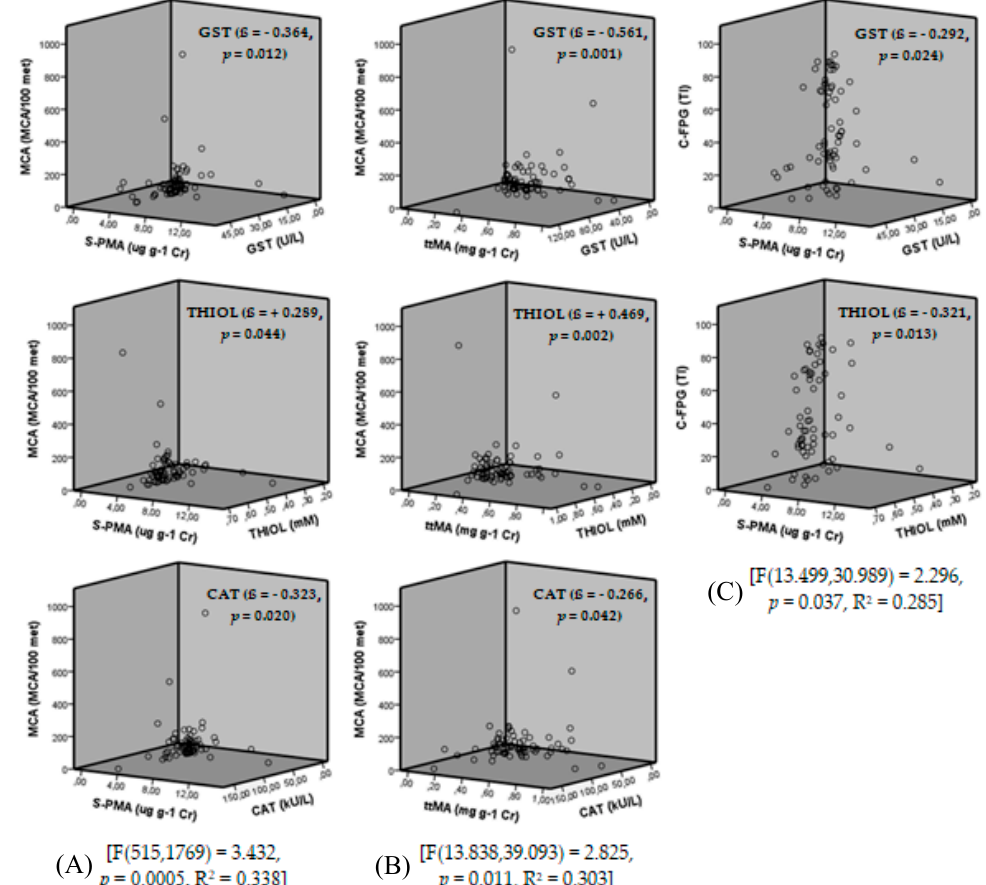
Figure 5. Plot of linearity between biomarkers of exposure, oxidative stress, and genotoxicity. ( A ) Multiple linear regression using MCA as a dependent variable and S -PMA, CAT, GST, THIOL, MDA, and C-FPG as predictor variables; ( B ) Multiple linear regression using MCA as a dependent variable and tt MA, CAT, GST, THIOL, MDA, and C-FPG as predictor variables; ( C ) Multiple linear regression using C-FPG as a dependent variable and S -PMA, CAT, GST, THIOL, MDA, and MCA as predictor variables. All the models were controlled by age and duration of exposure. The variables sex, alcohol use, tobacco use, and SOD did not influence the models obtained for the different dependent variables and were not used in the last model of regression.